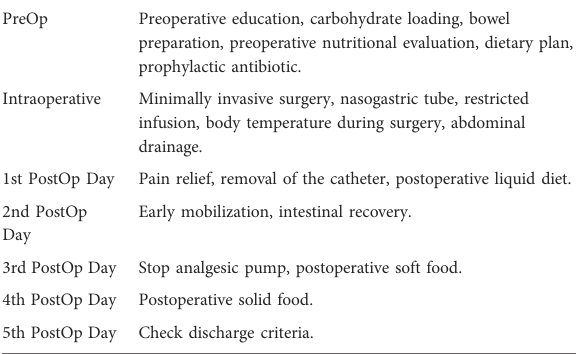
TABLE 1 ERAS protocols for colorectal cancer surgery a